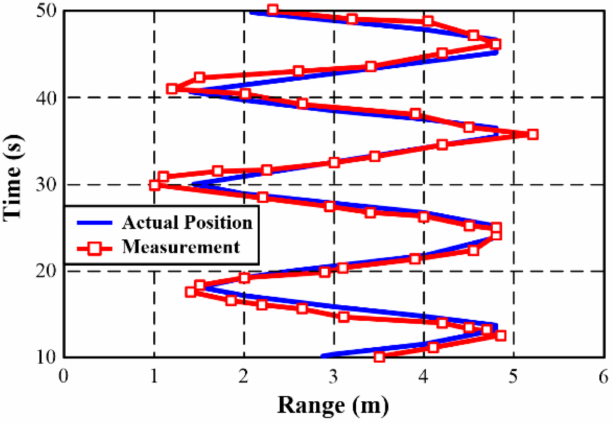
Figure 8. Range–time intensity (RTI) of proposed FMCW radar in indoor environment.